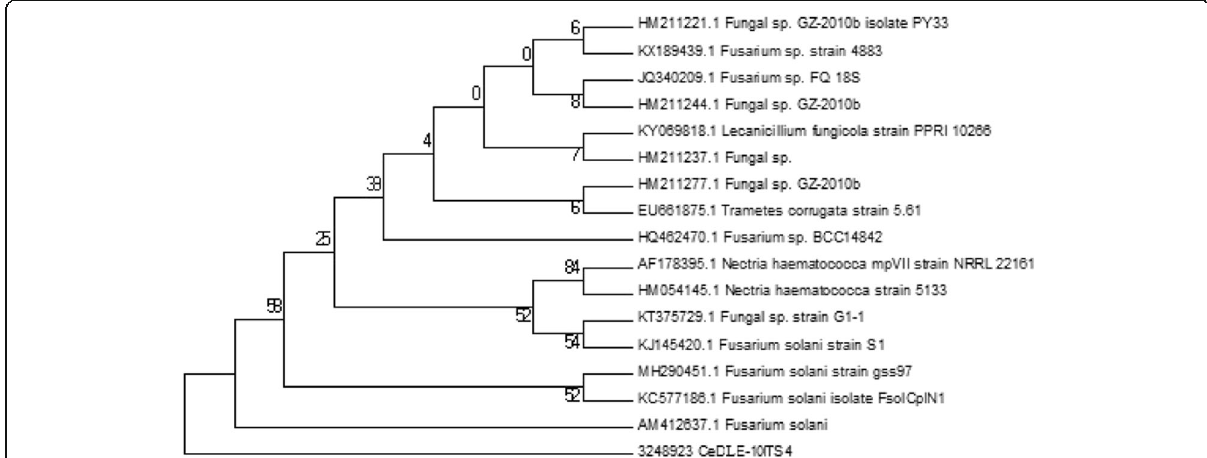
Fig. 6 Phylogenetic relationship for 5.8S-rRNA-ITS regions between the endophytic fungus CEDLE-10 and published data. Phylogenetic tree